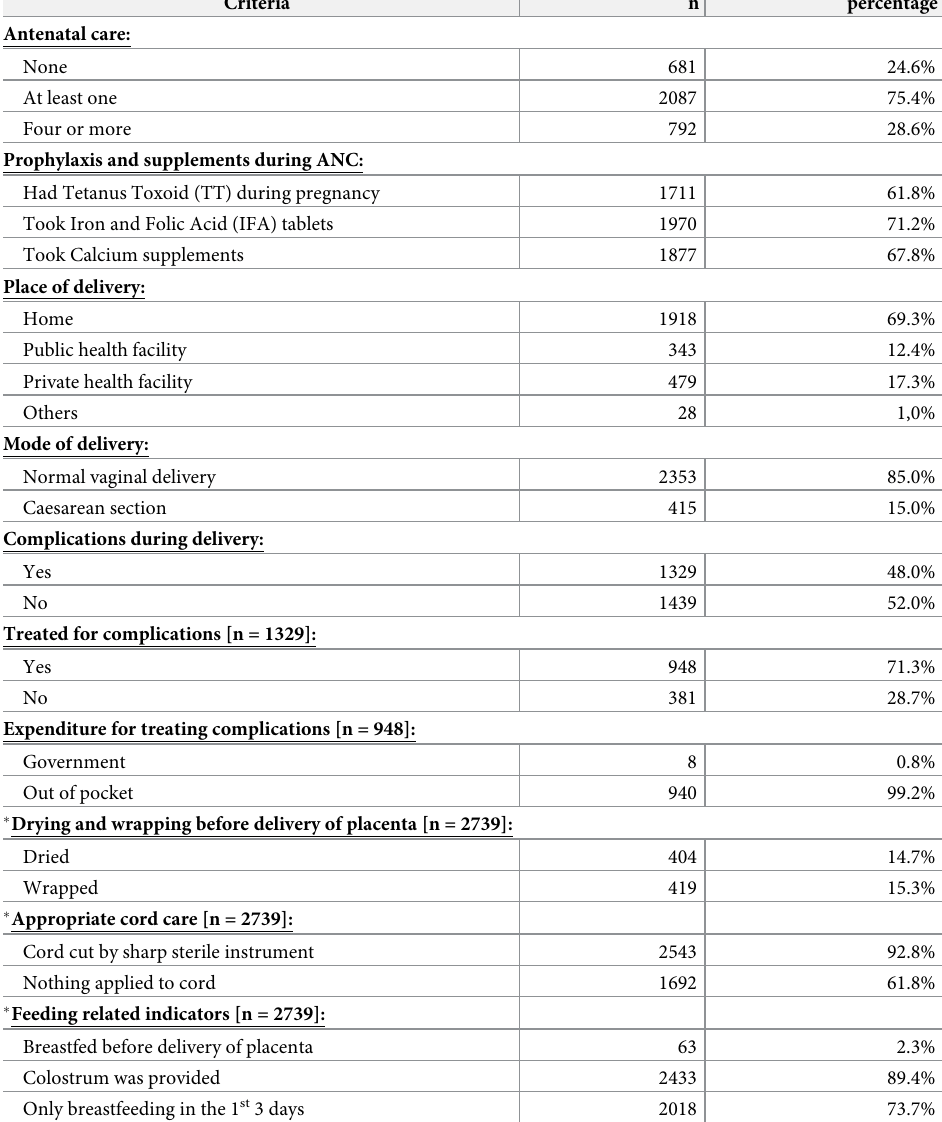
Table 5. Information related to MNH care among the study participants.